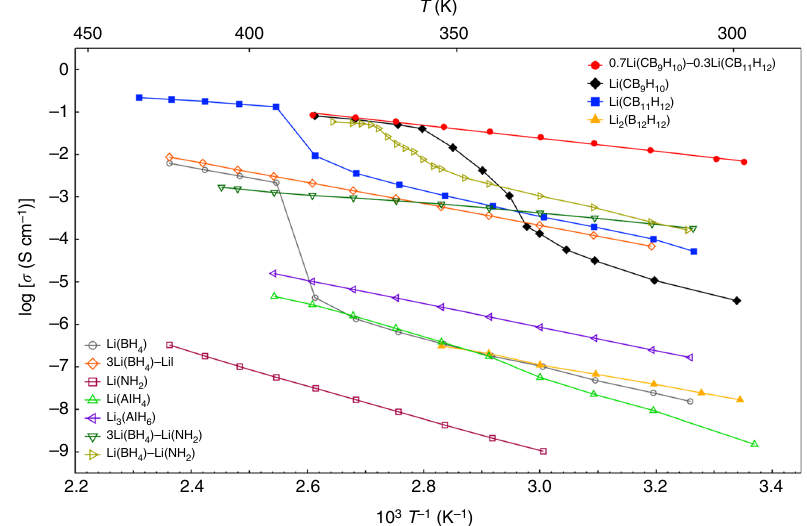
Fig. 3 Arrhenius plots of the conductivities of 0.7Li(CB 9 H 10 ) – 0.3Li(CB 11 H 12 ) and those of other complex hydride lithium ion conductors 23,24,41 – 46 . 0.7Li (CB 9 H 10 ) – 0.3Li(CB 11 H 12 ) exhibits a high lithium ion conductivity of 6.7 × 10 − 3 S cm − 1 at 25 °C, which is the highest value reported for complex